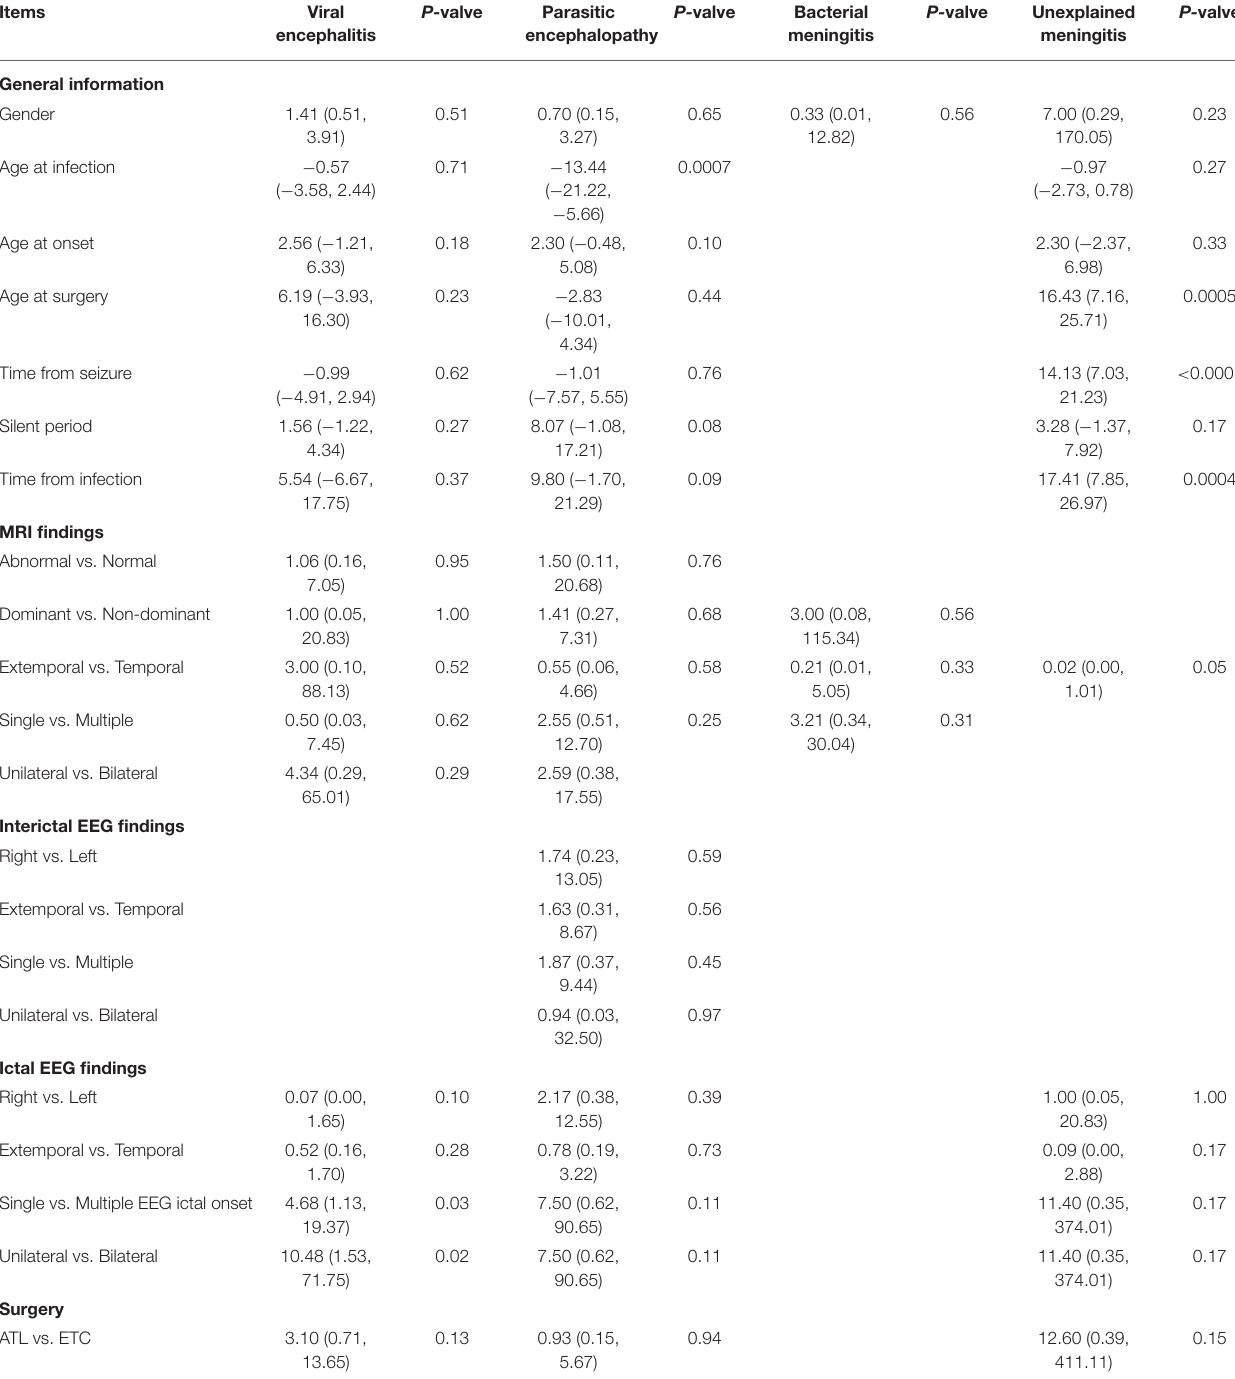
TABLE 3 | Subgroup analysis of primary